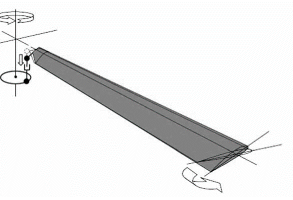
Figure 3. Helicopter individual blade control (IBC).